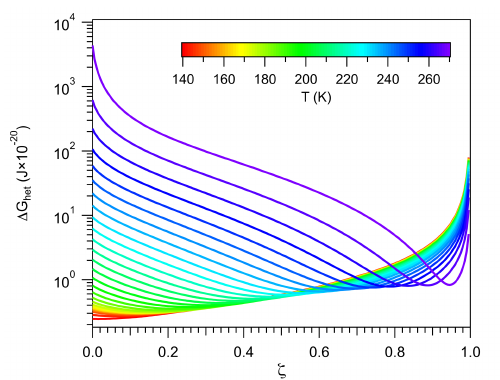
Figure 2. Work of heterogeneous ice nucleation. Color indicates different